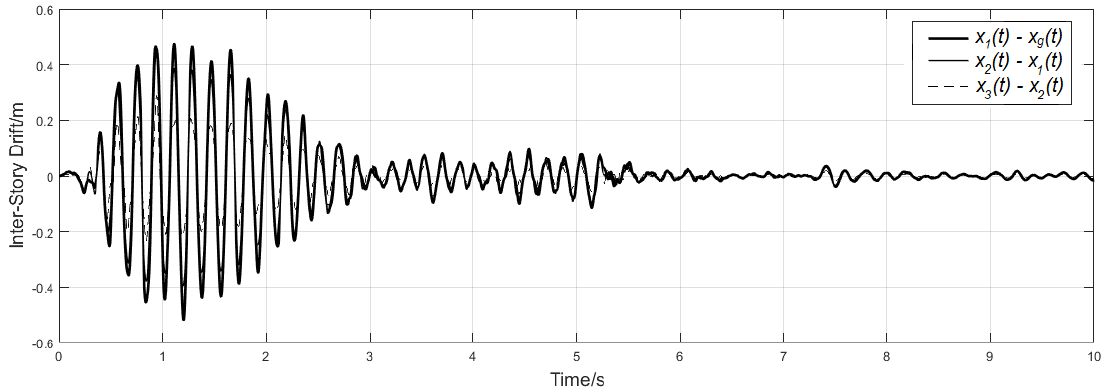
Figure 6. The inter-storey drift dynamic response of the building, without MR damper, to the earthquake signal represented at Figure